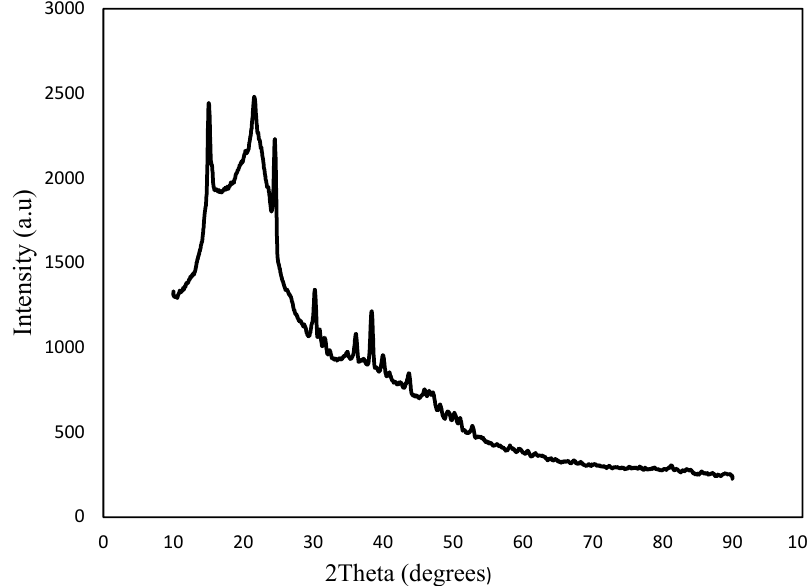
Figure 4. X–ray diffractogram for Aloe vera .